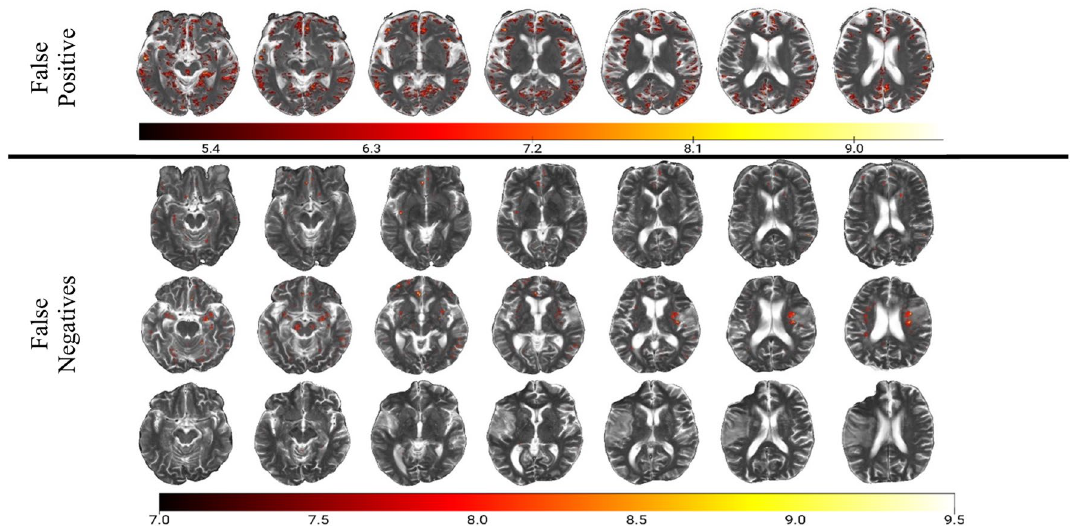
Figure 3. Analysis of misclassified patients. In the false positive case, the network seems to have picked up on remote infarcts that often resemble EPVS. In the false negative cases, there were less activations in the high range (> 7), i.e. activations were more